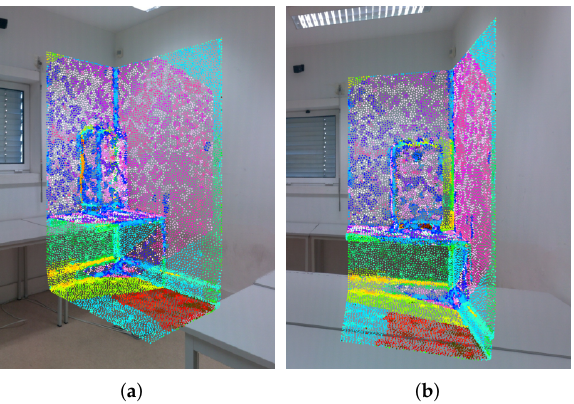
Figure 3. Pairwise mappings between image ( a ) and image ( b ). Points are colored to identify the mappings between images. For instance, in both images, the points in pink belong to the